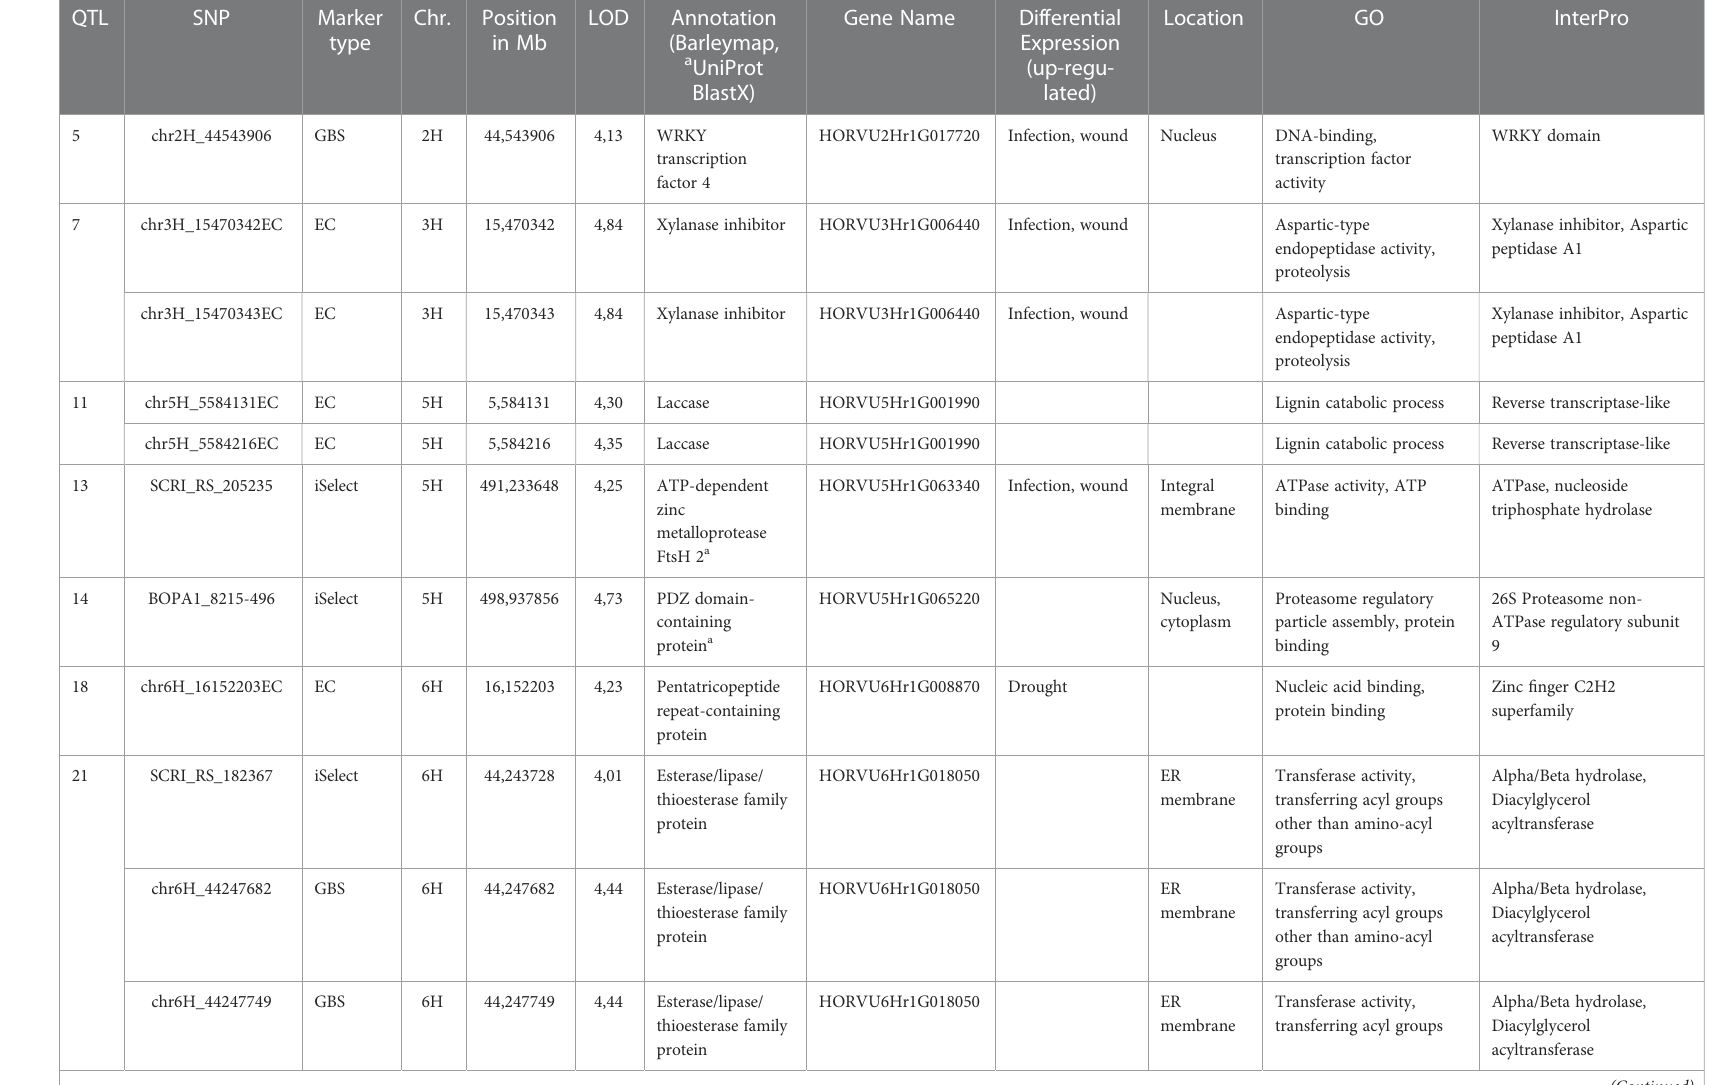
TABLE 3 In a genome ‐ wide association study (GWAS), based on the observed phenotypic differences and 493,846 fi ltered SNPs derived from the Illumina 9k iSelect (iSelect) chip, genotyping by sequencing (GBS), and exome capture data (EC), 11 quantitative trait loci (QTL) associated to improved resistance to P. hordei after priming with E. meliloti expR + ch , were identi fi ed with a peak on the short arm of the barley chromosome (Chr.)